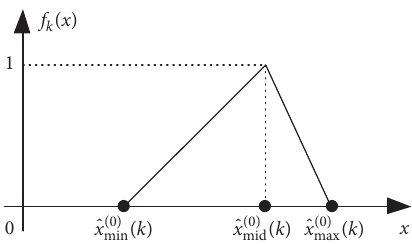
Figure 4: The possibility function of the simulated or predicted result ⊗ ( k ) of GM ( 1 , 1 , ⊗ b )